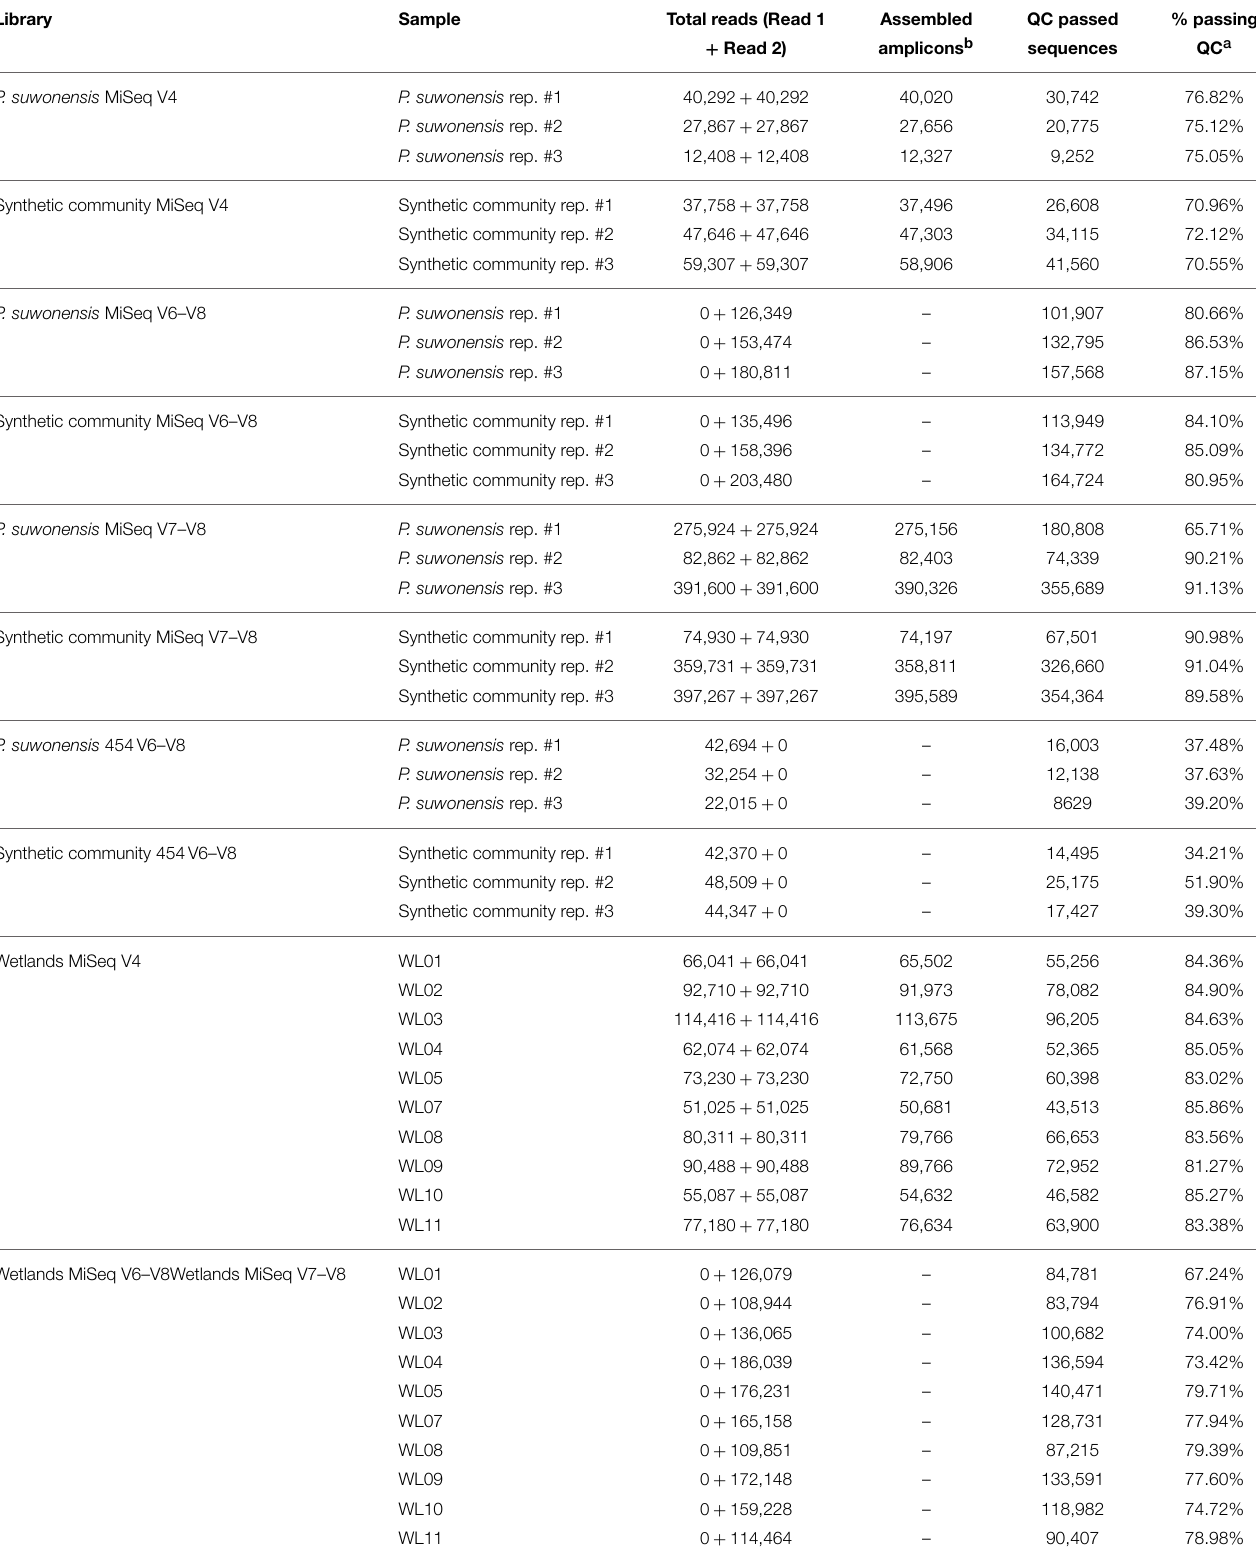
TABLE 1 | Reads count summary of full